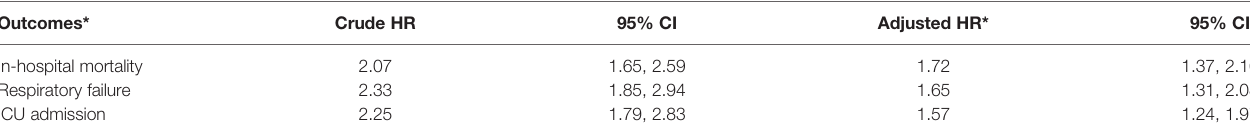
TABLE 4 | Association of having cancer with the different outcomes of interest (time-to-event analysis). Outcomes*